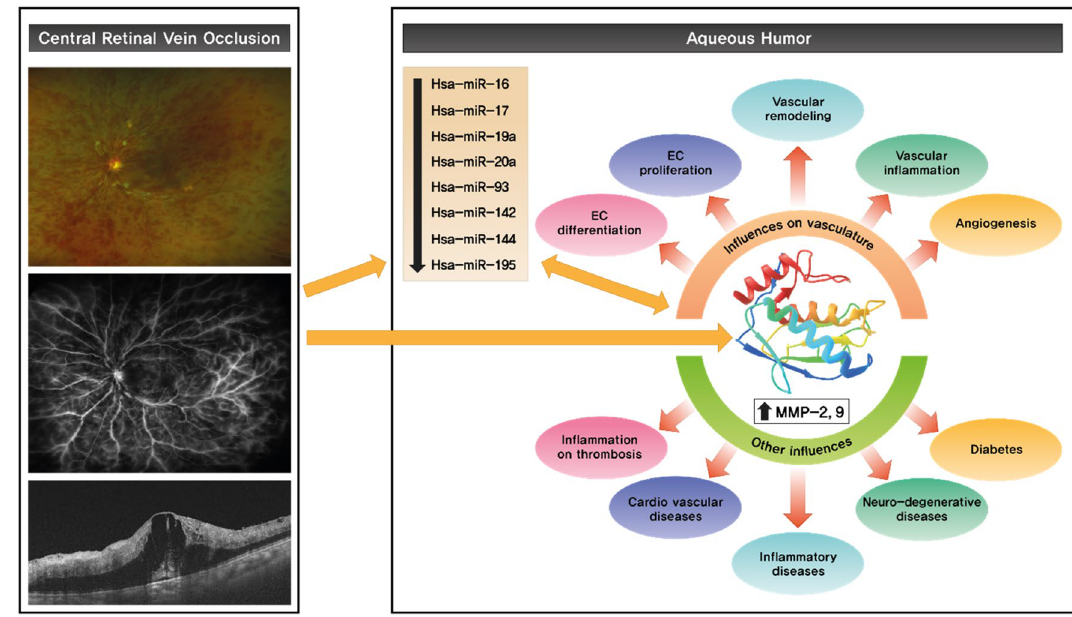
Figure 4. Schematic representation of the main findings. The left column shows the representative retinal images of patients with CRVO (no. 3. patients). Ultra-wide fundus photography (wFP) indicates diffuse retinal hemorrhage, cotton wool spots, and hard exudates. Fluorescein angiography (FA) indicates a diffuse nonperfusion area and vascular leakage. Optical coherent tomography (OCT) images indicate macular edema and ischemic retina. The right column indicates the aqueous humor findings, namely the decreased expression of miRNAs and increased activity of MMP-2 and -9, and the possible influences and roles of these